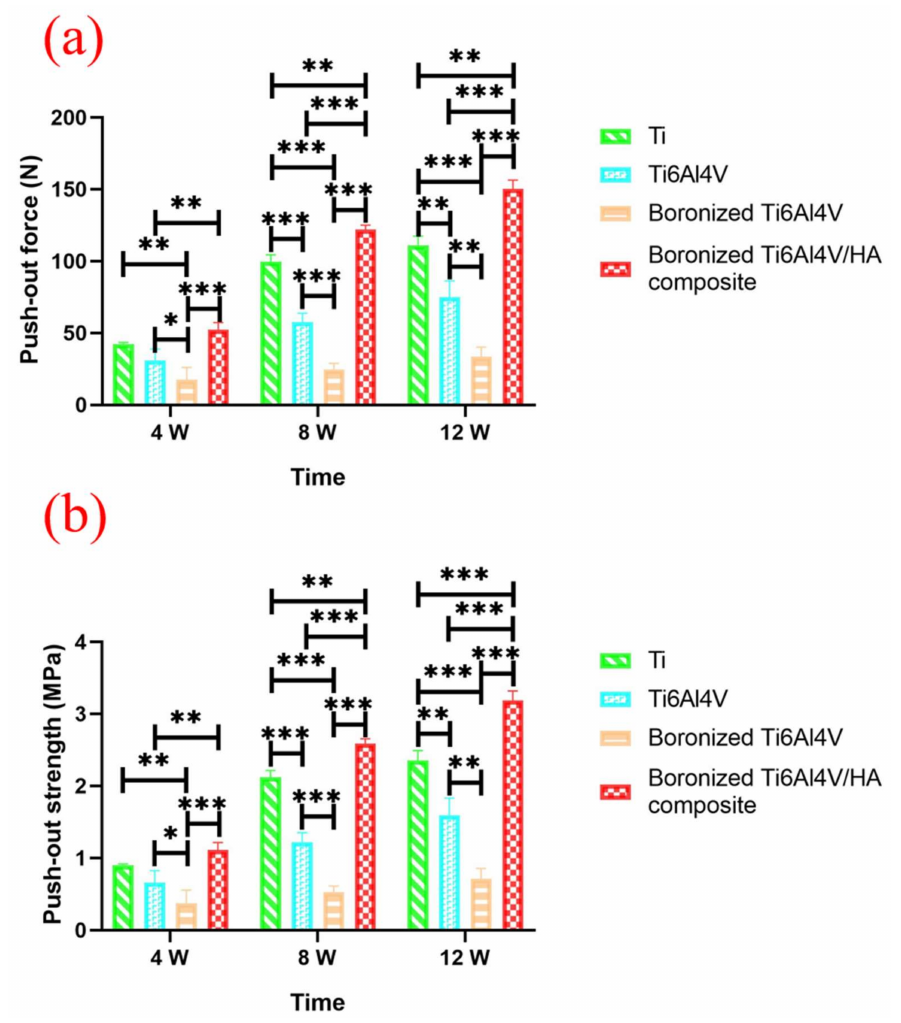
Figure 8. ( a ) Maximum push-out force and ( b ) push-out strength after surgery at the 4th, 8th, and 12th weeks (* p < 0.05, ** p < 0.01, and *** p <